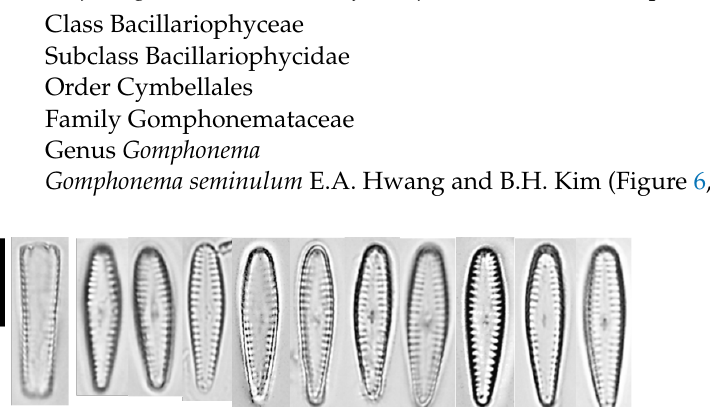
Figure 7. SEM of Gomphonema seminulum sp. nov. taken from holotype population (AG9005): ( A , B ) scale bar = 5 µm; ( C – H ) scale bar = 2 µm; ( A ) external view of whole valve; ( B ) internal view of whole valve; ( C ) external view of head pole; ( D ) external view of valve middle, showing the stigma on central area of valve face (arrow); ( E ) internal view of foot pole, showing the apical pore field (arrow); ( F ) internal view of head pole, showing the helictoglossa (arrow), pseudosepta (arrow P); ( G ) internal view of valve middle, showing the alveoli (arrow); ( H ) internal view of foot pole, show- ing the pseudosepta (arrow). Remarks: In this study, we conducted LM and SEM to study the morphology of G. seminulum and confirmed new species belonging to the genus Gomphonema . The morphol- ogy of G. seminulum differs from closely related taxa (Table 5); among them, G. bourbonense [36], which lacks descriptions of ultrastructure, was further analyzed by examining type material (specimen ID TCC441, TCC458, TCC930 in the Thonon Culture Collection,